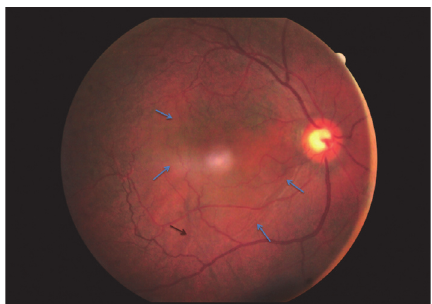
Figure 1: Fundus picture of the right eye showing large serous macular detachment (SMD) (blue arrow) and choroidal folds (brown arrow) at the posterior pole.